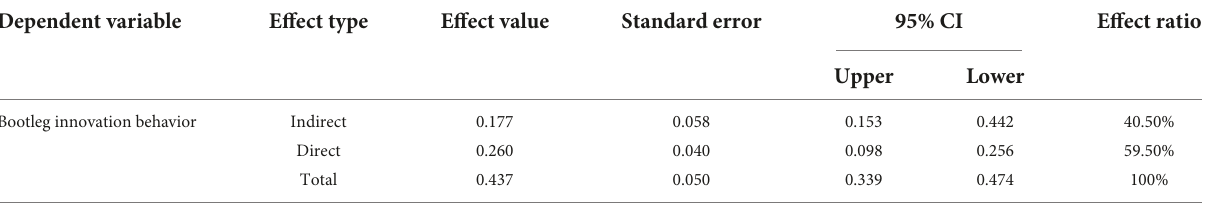
TABLE 4 Results of robustness tests of the intermediary